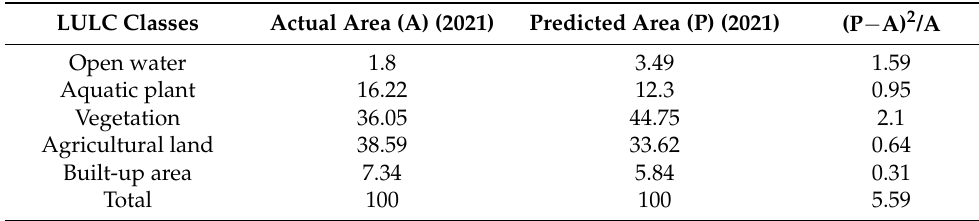
Table 5. Validation of change prediction based on actual (2021) and predicted (2021) LULC map using the Chi-square test ( X 2 ). Actual Area (A)